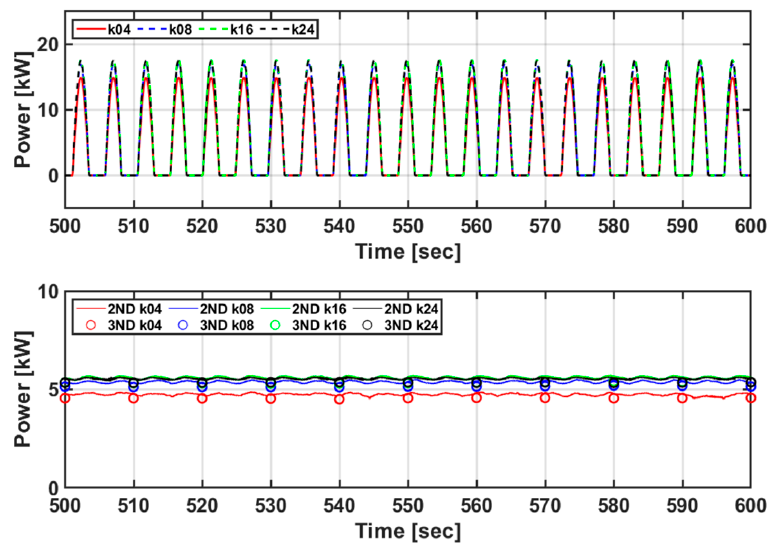
Figure 15. Power generation comparison according to torque coefficient of optimal torque control algorithm under regular wave conditions (legends indicate torque coefficients). Table 2. Input and output power according to the torque coefficient of the optimal torque control algorithm and the efficiency of the PTO system.